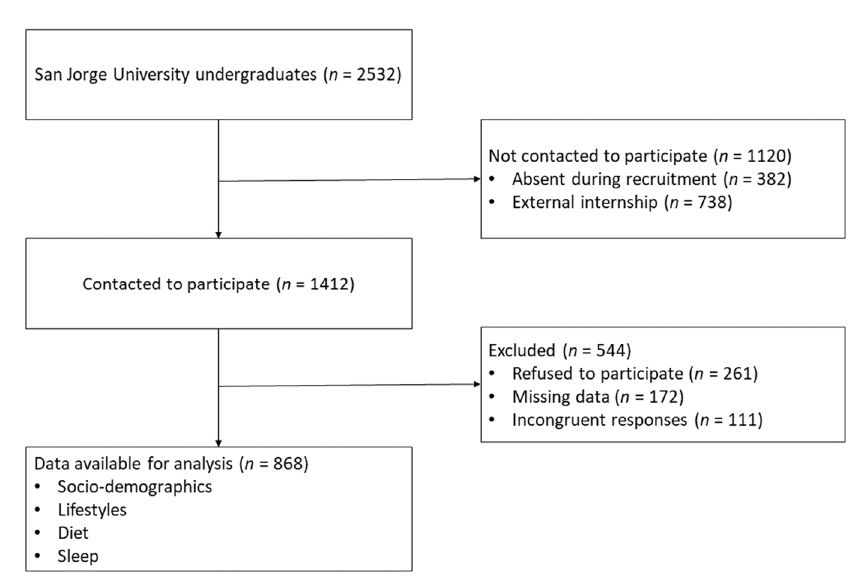
Figure 1. Participant selection flowchart.